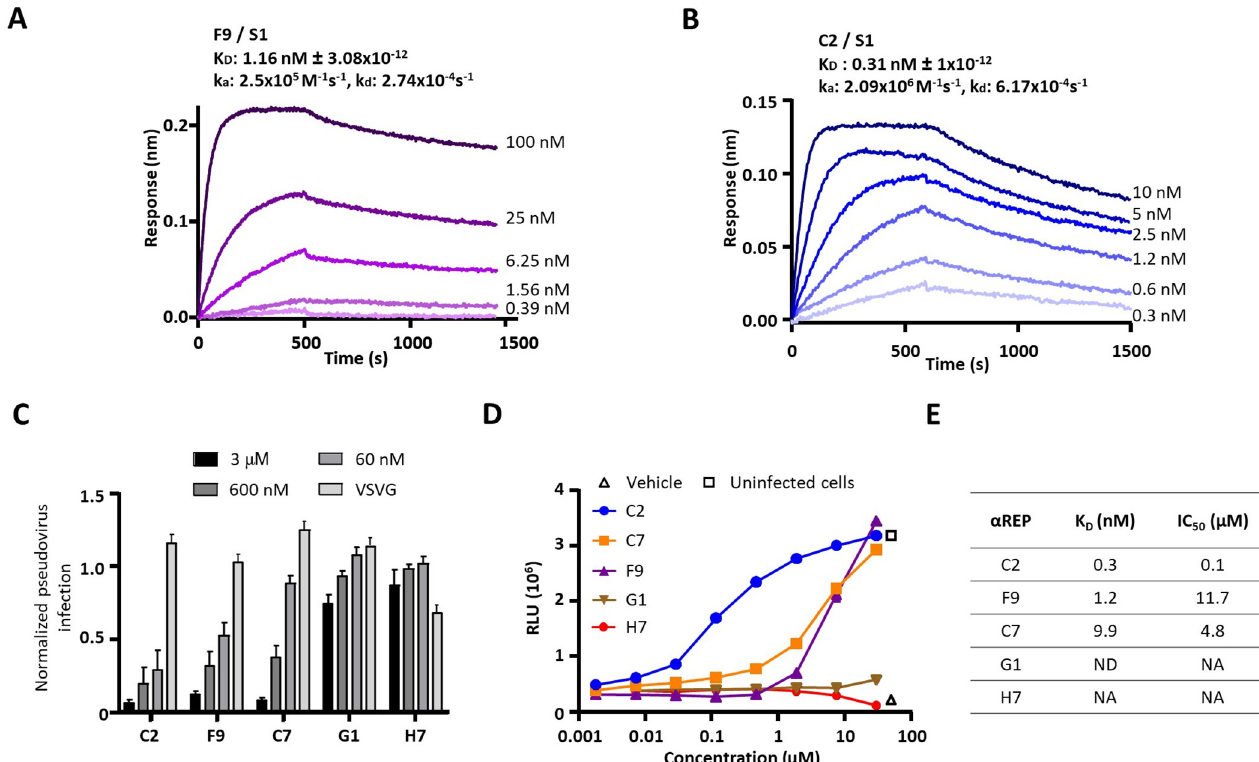
Fig 2. Selection of α Reps based on their affinities and neutralization activities. BLI binding kinetics measurements are shown for F9 ( A ) and C2 (B ). Equilibrium dissociation constants (K D ) were determined on the basis of fits, applying 1:1 interaction model; ka, association rate constant; kd, dissociation rate constant. (C) Pseudo-typed SARS-CoV-2 neutralization assay was shown with selected α Rep (C2, F9, C7, G1). An α Rep specific to influenza polymerase (H7) was chosen as a negative control. To assess α Reps specificity, pseudo-typed VSV-G were incubated with the highest concentration of each α Rep (3 μ M). Pseudo-type particles entry into cells was quantified by measuring luciferase activity (n = 3, mean ± SEM, two-way ANOVA, � P < 0.05). (D) Cell viability of infected cells in presence of dilutions of α Reps C2, C7, F9, G1 and H7 was monitored using the CellTiter-Glo Luminescent Assay Kit (Promega). Infected cells (triangle) and mock-infected cells (square) were included in the assay as controls (n = 2, mean is presented). (E) Half maximal inhibitory concentration (IC 50 ) were calculated using “log(inhibitor) vs. normalized response” equation from the neutralization potency curves with GraphPad Prism 8 software. ND: Not done, NA: Not available.